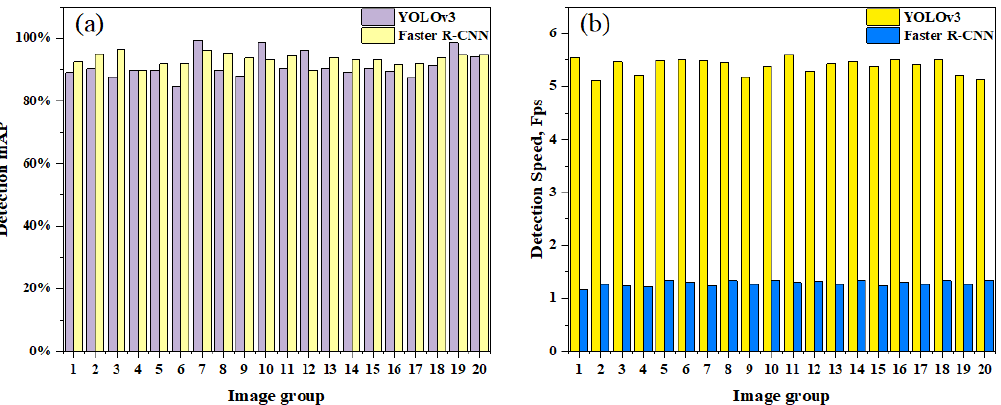
Figure 12. Comparison of detection performance between Faster R-CNN and YOLOV3. ( a ) Mean average precision (mAP); ( b ) Speed.